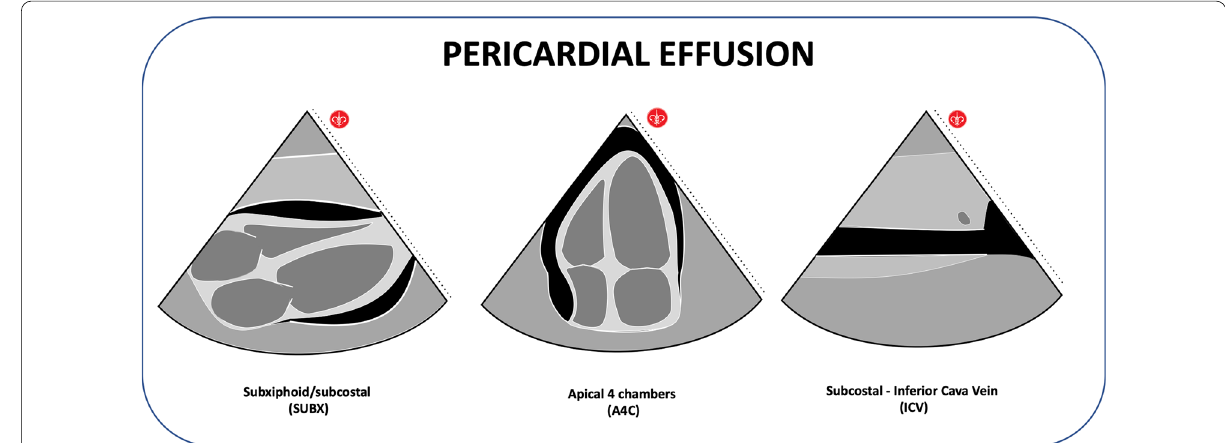
Fig. 4 Pericardial effusion and Cardiac tamponade findings